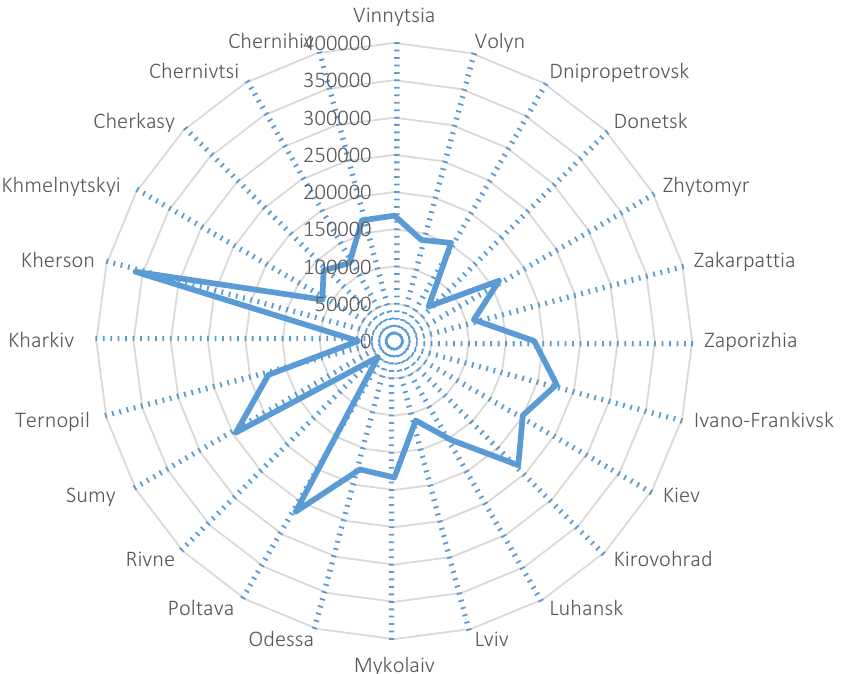
Figure 3. Indicators of the efficient regulation of land relations associated with the involvement of the unemployed in entrepreneurial activity, UAH/persons